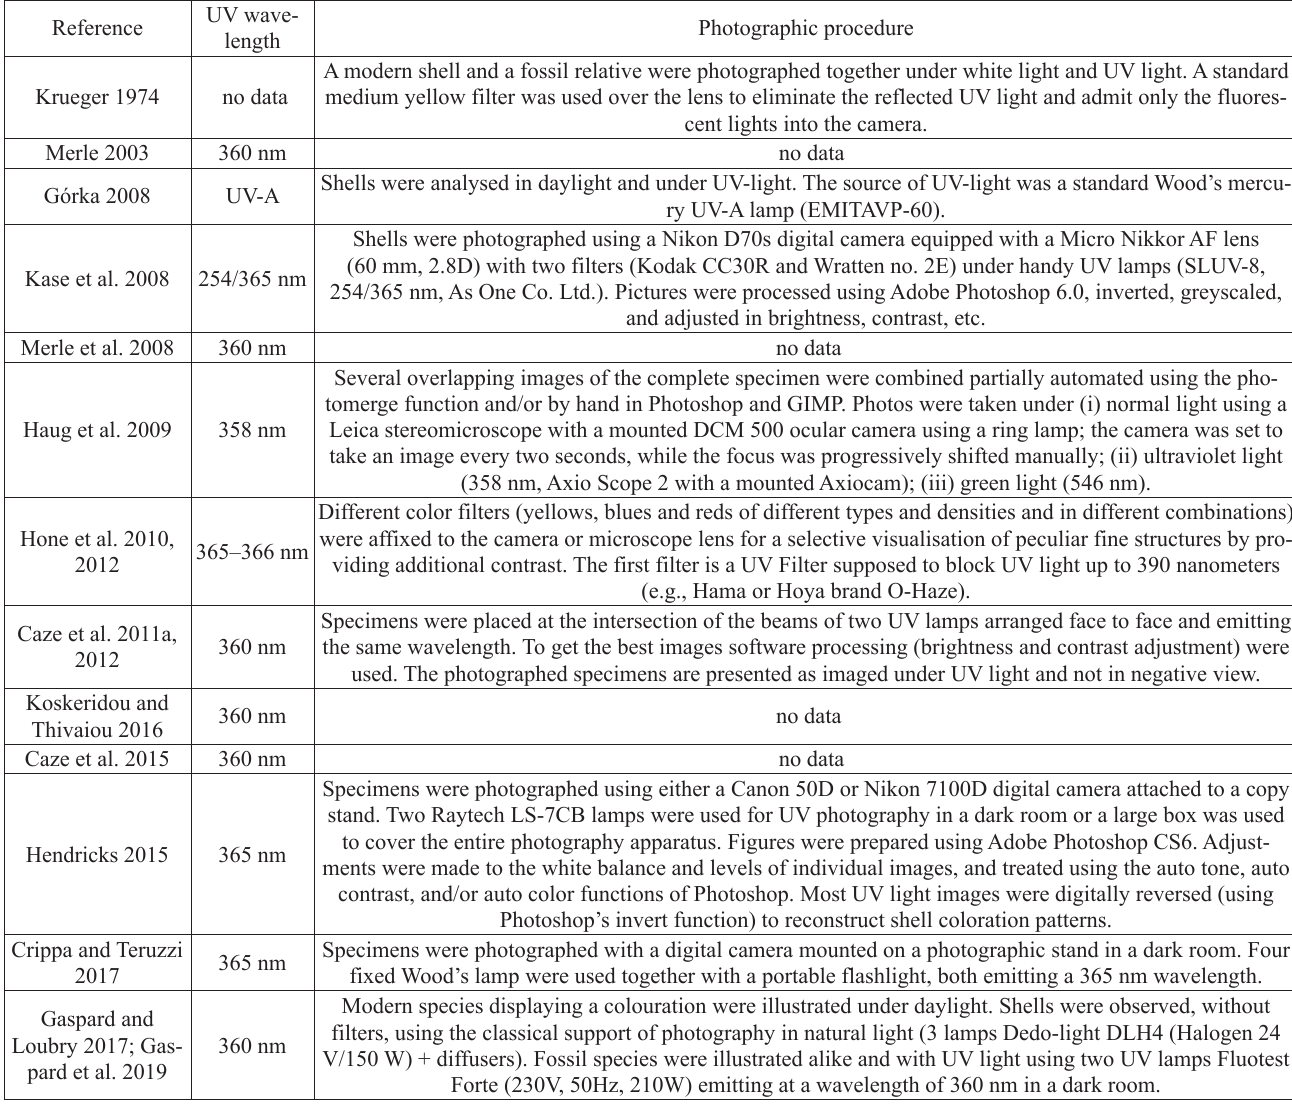
Table 2. Photographic techniques and UV wavelengths used in different studies.